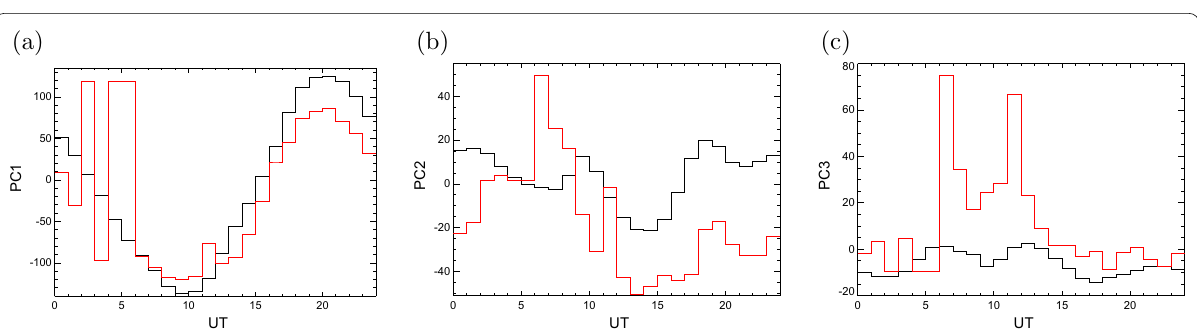
Fig. 10 Daily variations of the average PC coefficients at the times of a significant substorm activity (red curves) and at the times of no substorm activity (black